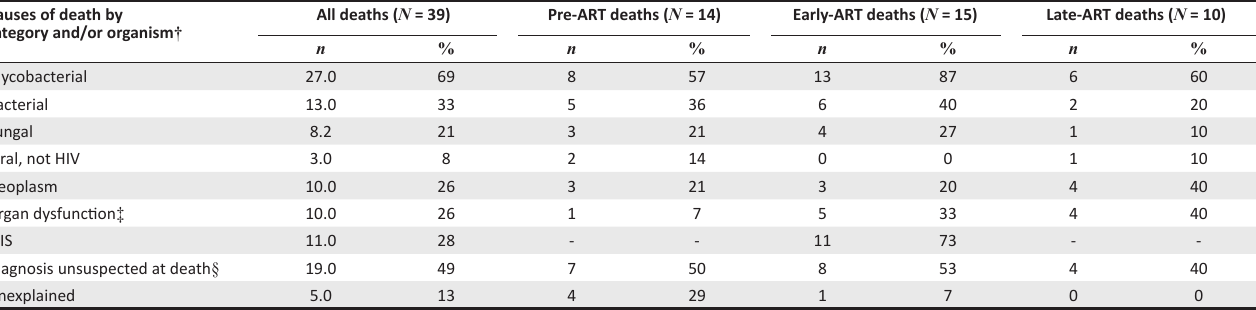
TABLE 1: Causes of death at post-mortem examination of 39 HIV-infected patients of the Charlotte Maxeke Johannesburg Academic Hospital, January–December 2009. 9 Causes of death by All deaths ( N = 39) category and/or organism †